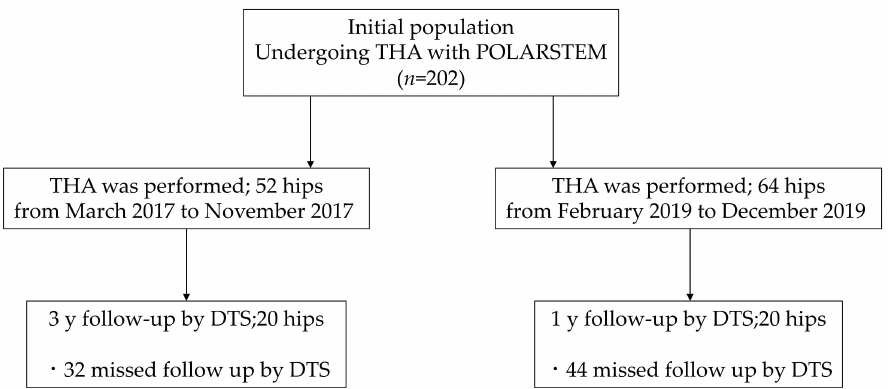
Figure 3. Flow diagram of the study